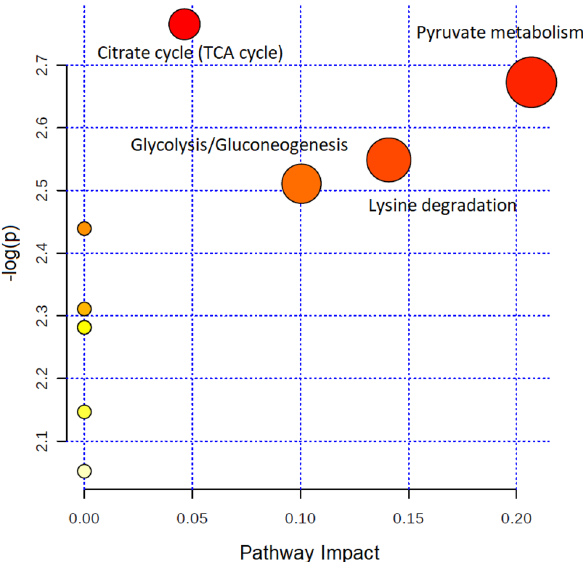
Figure 4. Topology-based pathway analysis showing metabolic pathways affected in lung cancer. The metabolome view shows matched pathways according to the p values from the pathway enrichment analysis and pathway impact values from the pathway topology analysis. The most impacted metabolic pathways are specified by the volume and color of the spheres (yellow, least relevant; red, most relevant) according to their statistical relevance p and impact values.